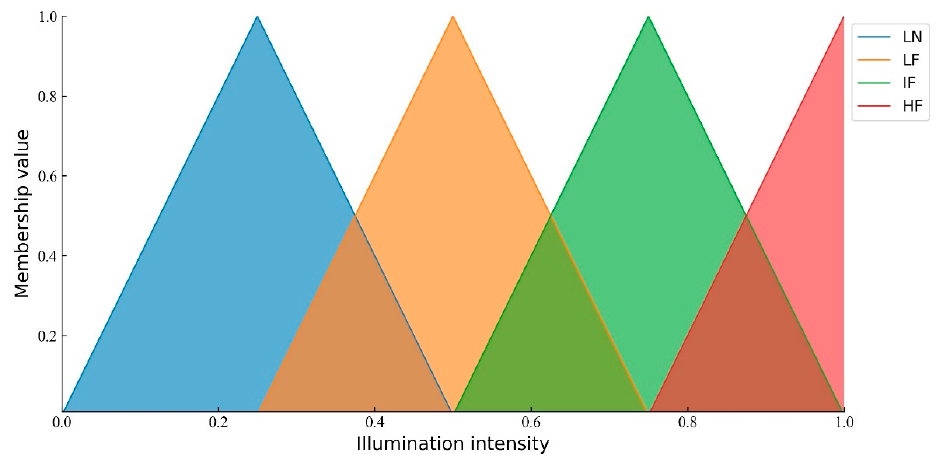
Figure 7. Triangular membership functions.